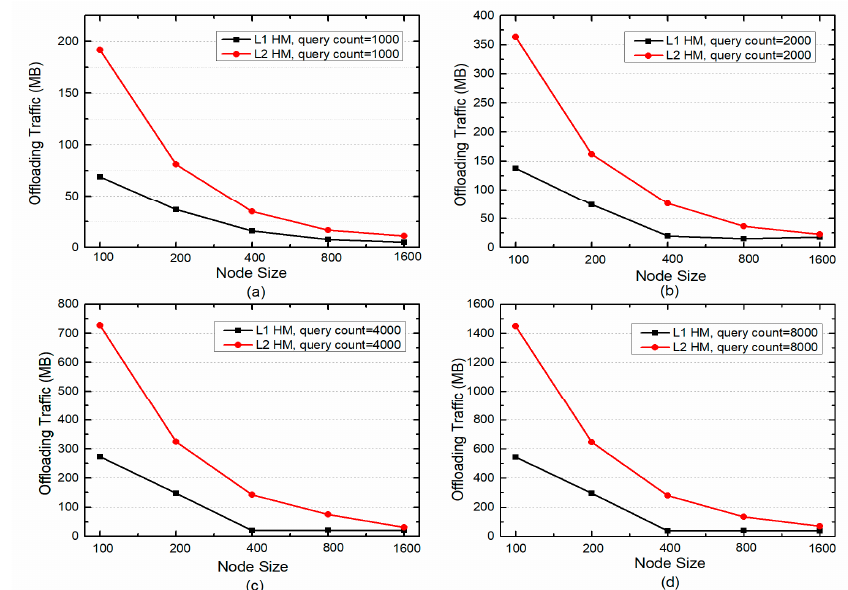
Figure 8. The total o ffl oading tra ffi c (MB) in di ff erent levels of HMs in ENRS with di ff erent query counts. ( a ) demonstrate the variation of o ffl oading tra ffi c in L 1 and L 2 HMs with di ff erent number of nodes when the query count is 1000. ( b – d ) demonstrate the variation of o ffl oading tra ffi c in L1 and L2 HMs with di ff erent number of nodes when the query counts are 2000, 4000 and 8000 respectively.